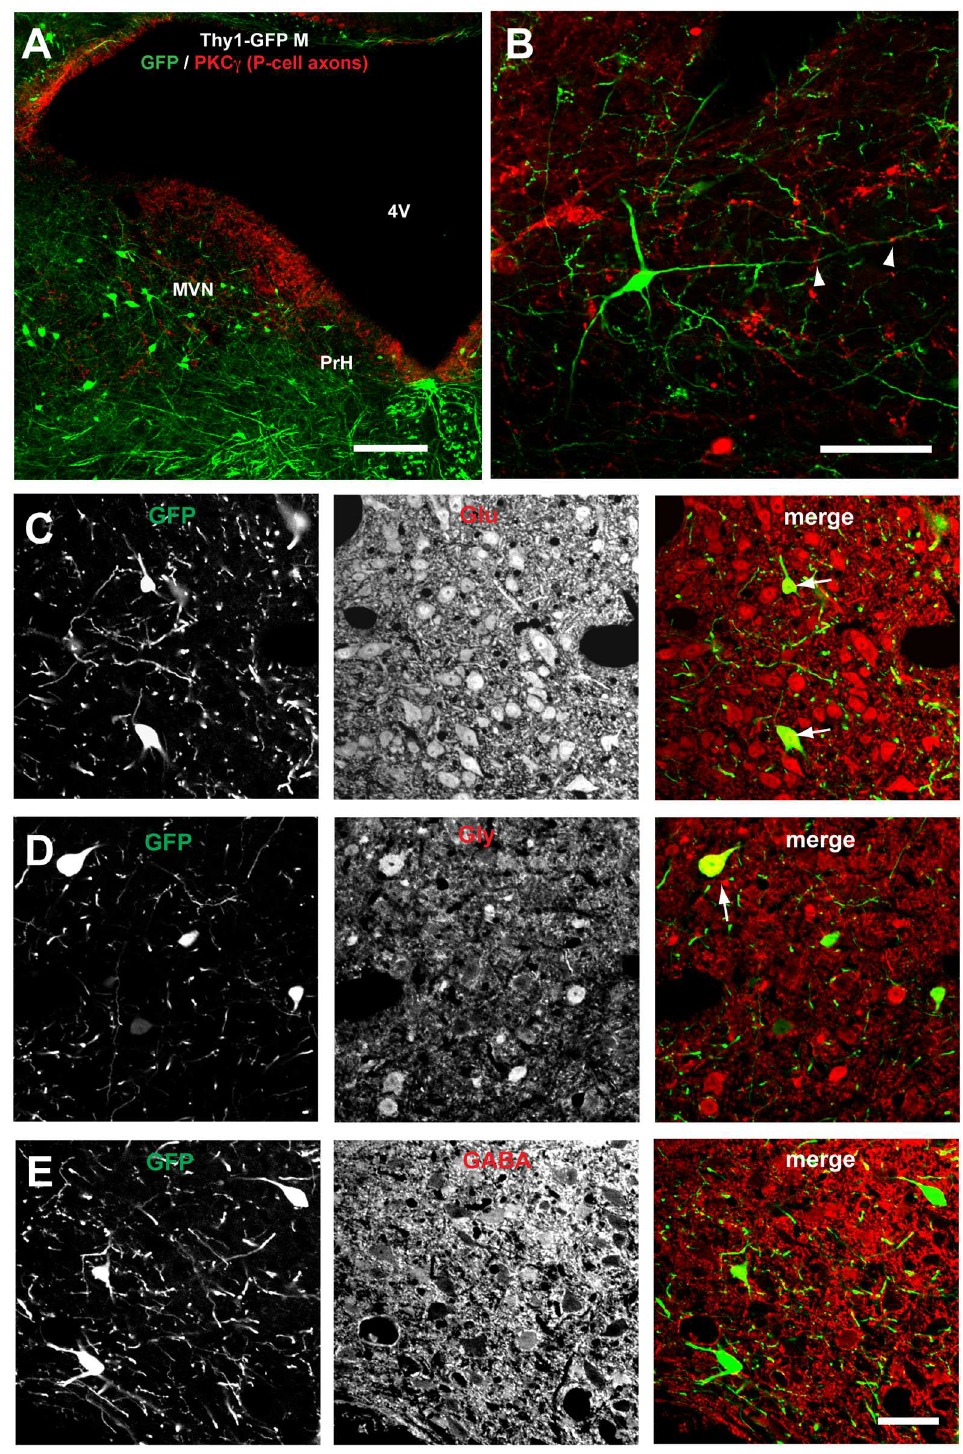
Fig 4. Neurons that receive FL P-cell projections on their distal dendrites in the parvocellular MVN/PrH are predominantly glutamatergic. A and B , Representative images of MVN/PrH neurons of Thy1-GFP M- line transgenic mouse that were stained with anti-GFP (green) and anti-PKC γ (red) antibodies. C , D , and E , Images of coronal sections of MVN/PrH stained with either one of three antibodiesagainst neurotransmitters (anti-Glu, anti-Gly, and anti-GABA). The majority of GFP-labeled neurons were stained positive for